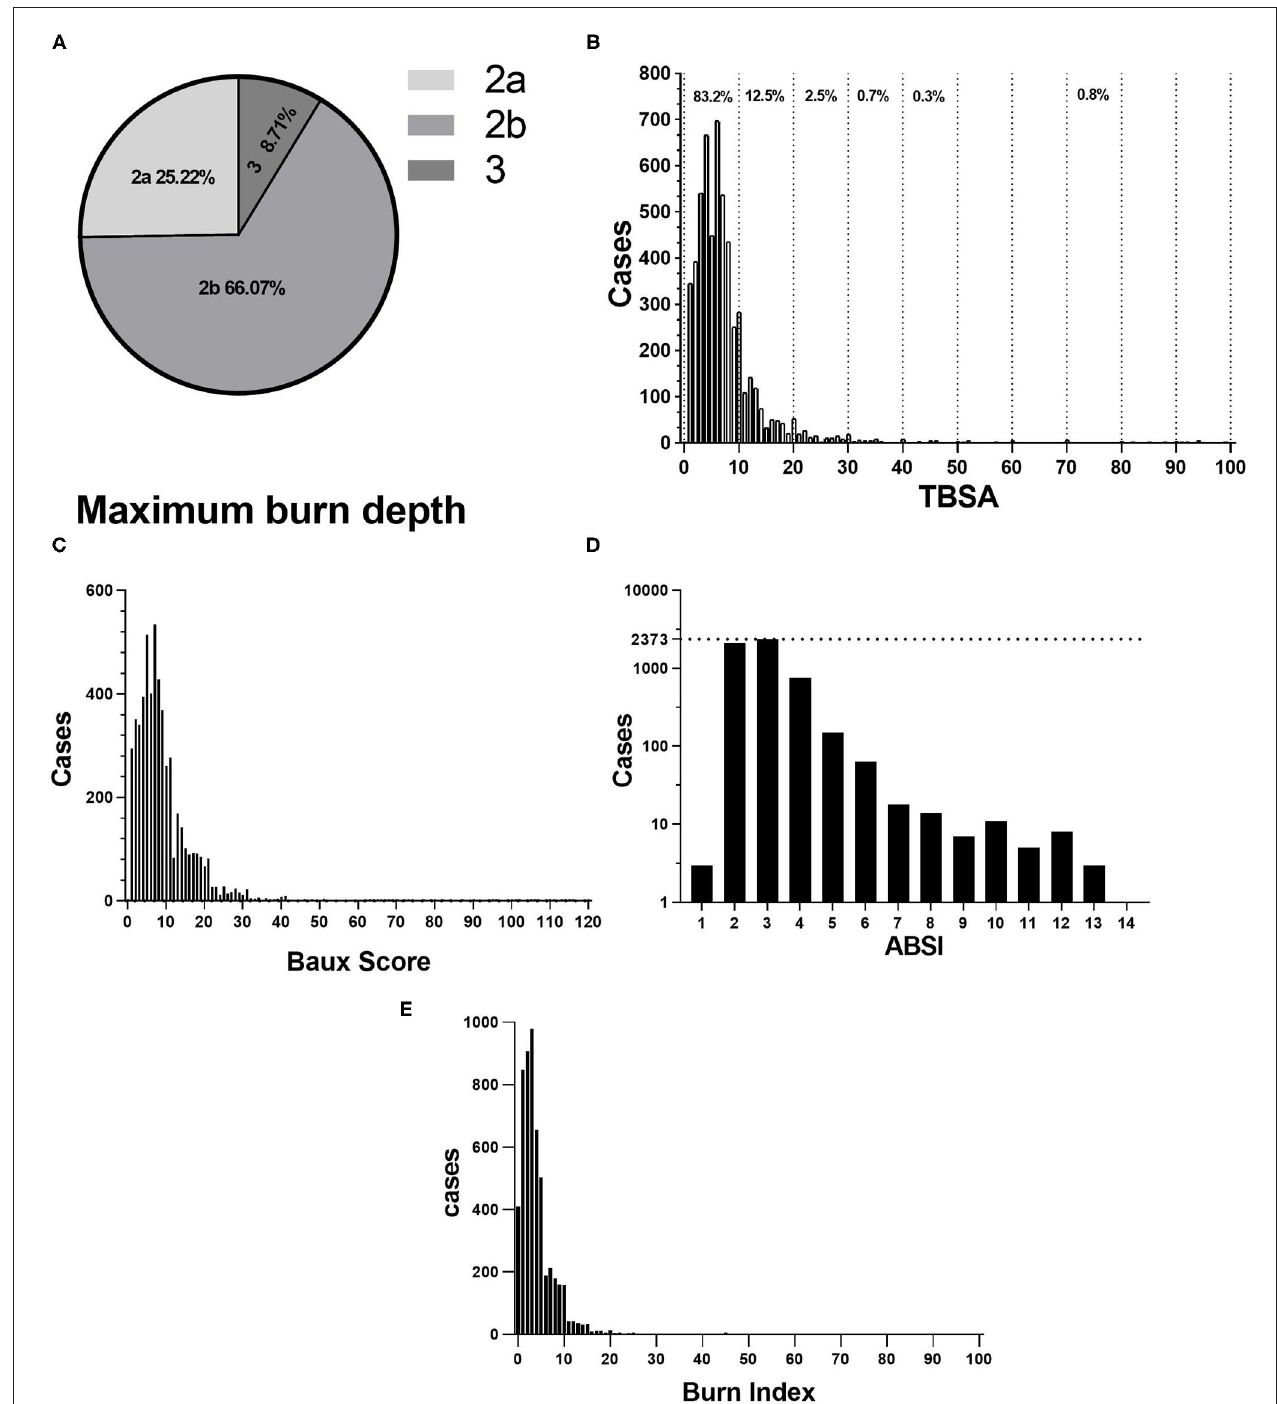
FIGURE 3 | (A) Proportion of Maximum burn dept. 2a for superficial partial-thickness burns, 2b for deep partial-thickness burns, 3 for full-thickness burns. (B) Distribution of TBSA. (C) Distribution of Baux score. (D) Abbreviated Burns Severity Index (ABSI). (E) BI.